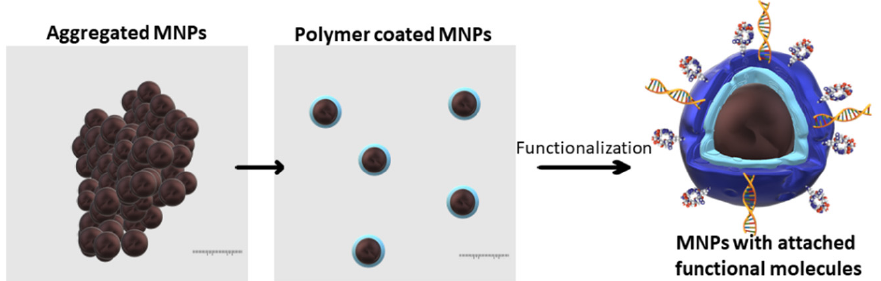
Figure 3. Schematic representation of polymer-coating features. Polymer shell usually provides higher colloidal stability and possible surface modification by functional, reporter, and targeting molecules (nucleic acids, antibodies, vitamins, etc.).